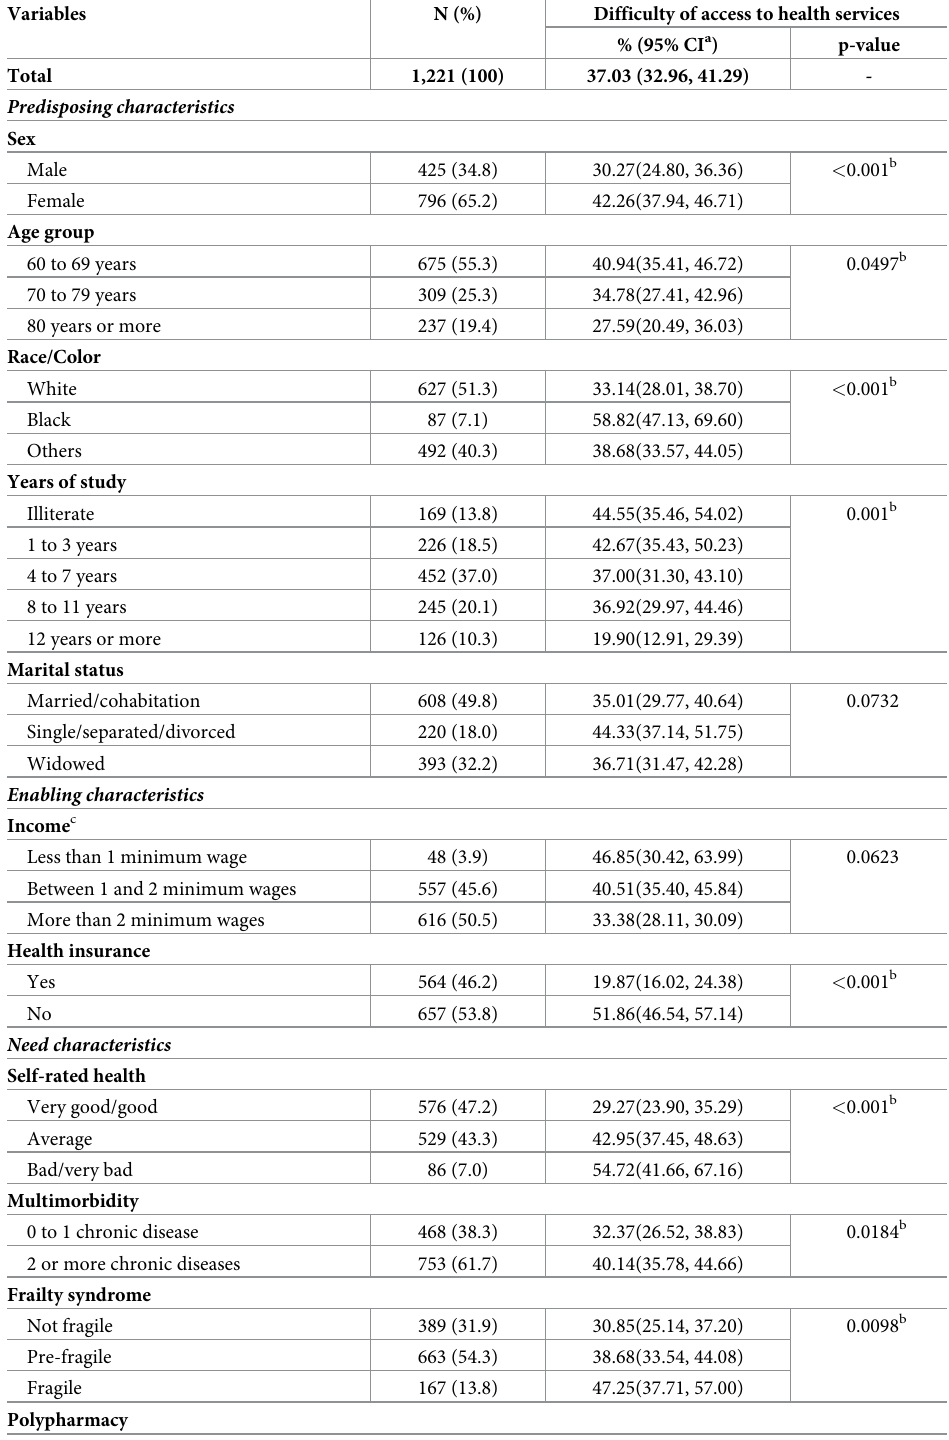
Table 1. Distribution of the elderly according to the difficulty of access to health services, predisposing, enabling and health need characteristics. SABE Study, S ã o Paulo, Brazil,